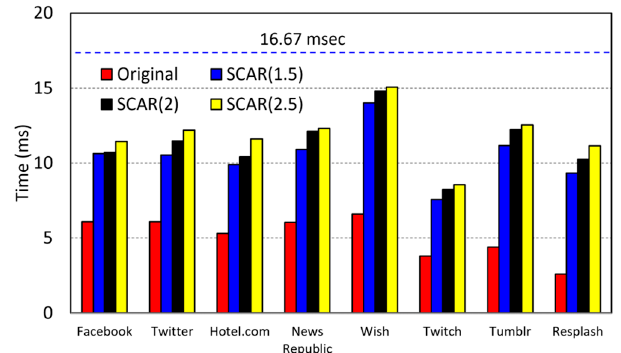
Figure 16. Total time spent to complete a frame rendering operation after a V-Sync signal.